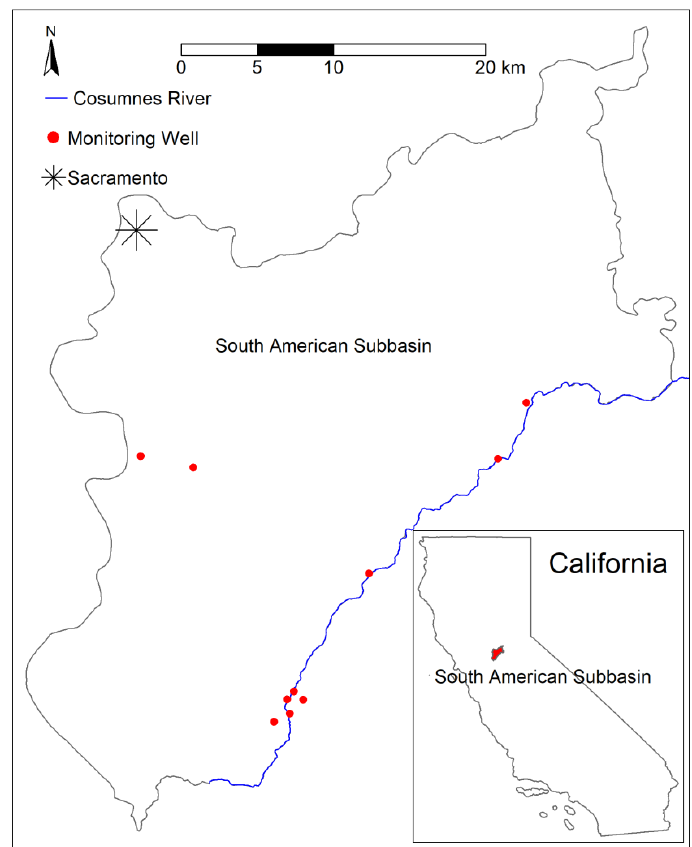
Figure 2. The Groundwater Observatory (GWO) network in the South American River Subbasin in central California, USA. The red polygon in the inset map indicates the range of the subbasin, and the red dots in the map show monitoring well locations outfitted with telemetry.